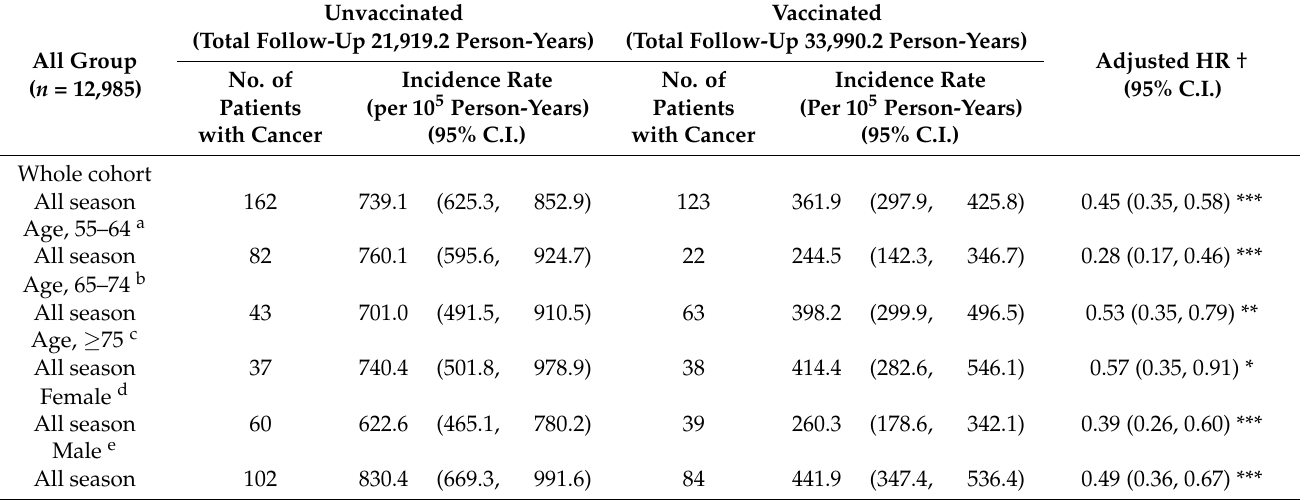
Table 2. Risk of liver cancer among unvaccinated and vaccinated in study cohort.